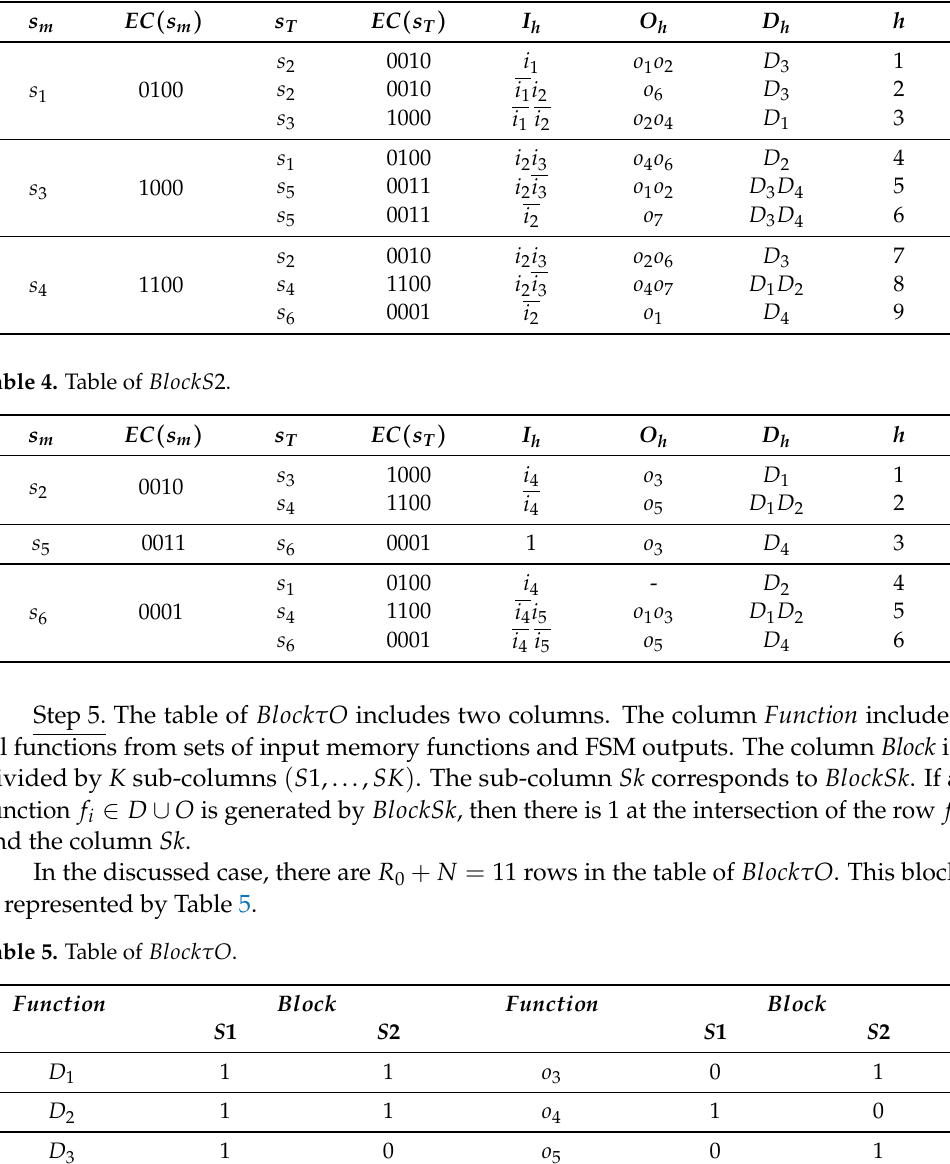
Table 3. Table of BlockS 1.